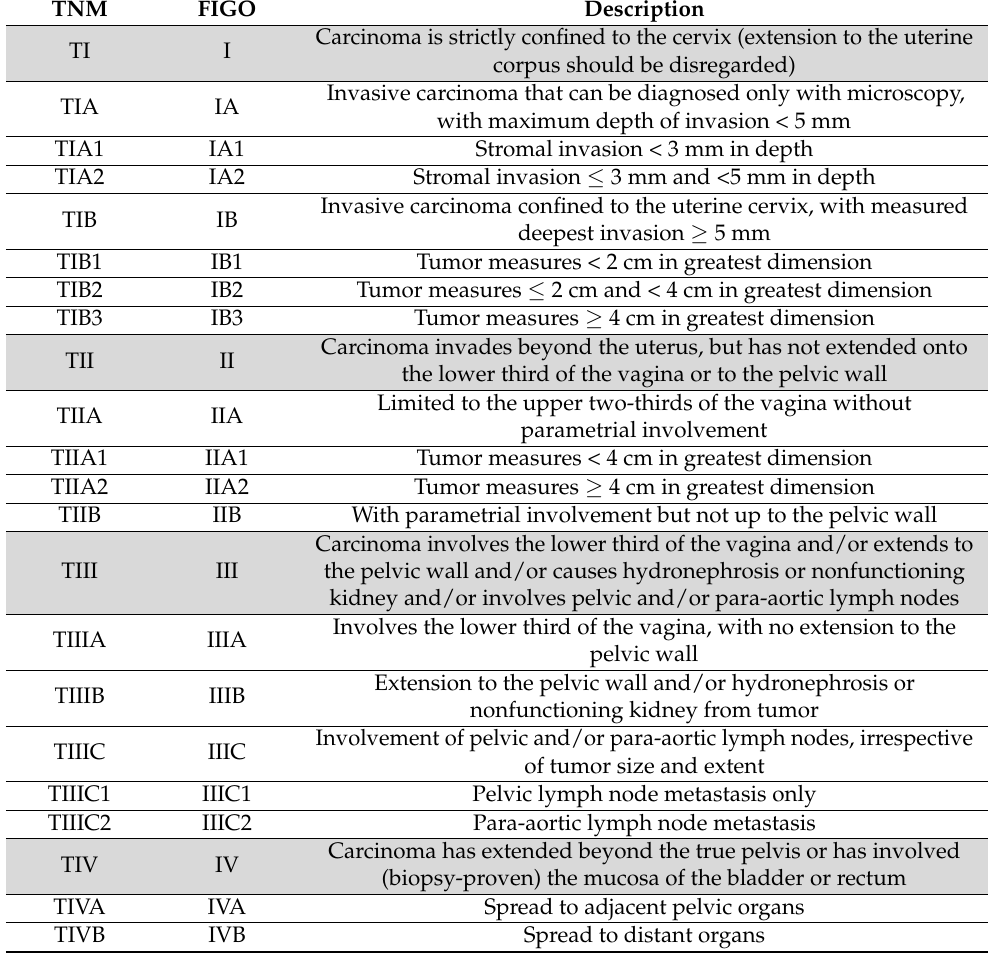
Table 1. TNM classification 8th edition and 2018 FIGO Staging System for Uterine Cervical Cancer. TNM FIGO Description Carcinoma is strictly confined to the cervix (extension to the uterine TI I corpus should be disregarded) Invasive carcinoma that can be diagnosed only with microscopy, TIA IA with maximum depth of invasion < 5 mm IA1 Stromal invasion < 3 mm in depth Stromal invasion ≤ 3 mm and <5 mm in